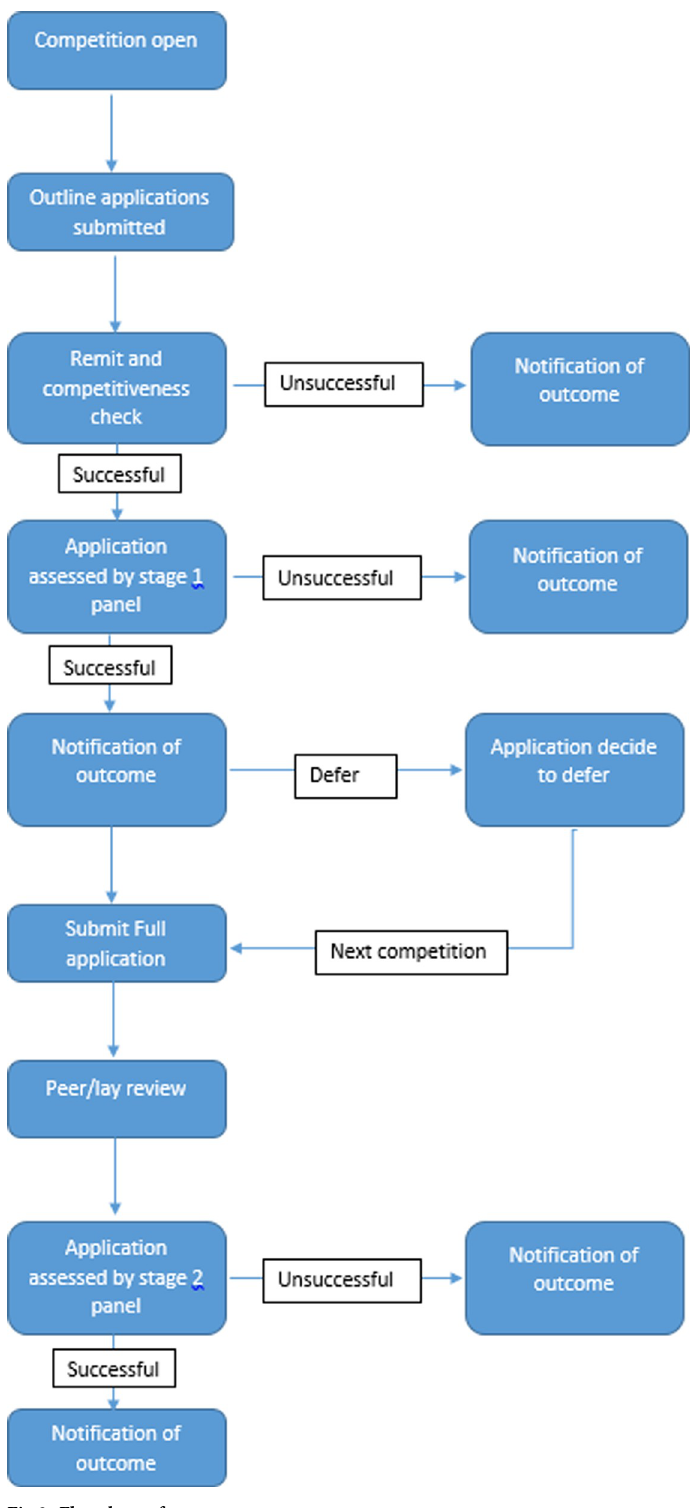
Fig 2. Flowchart of two-stage assessment process.